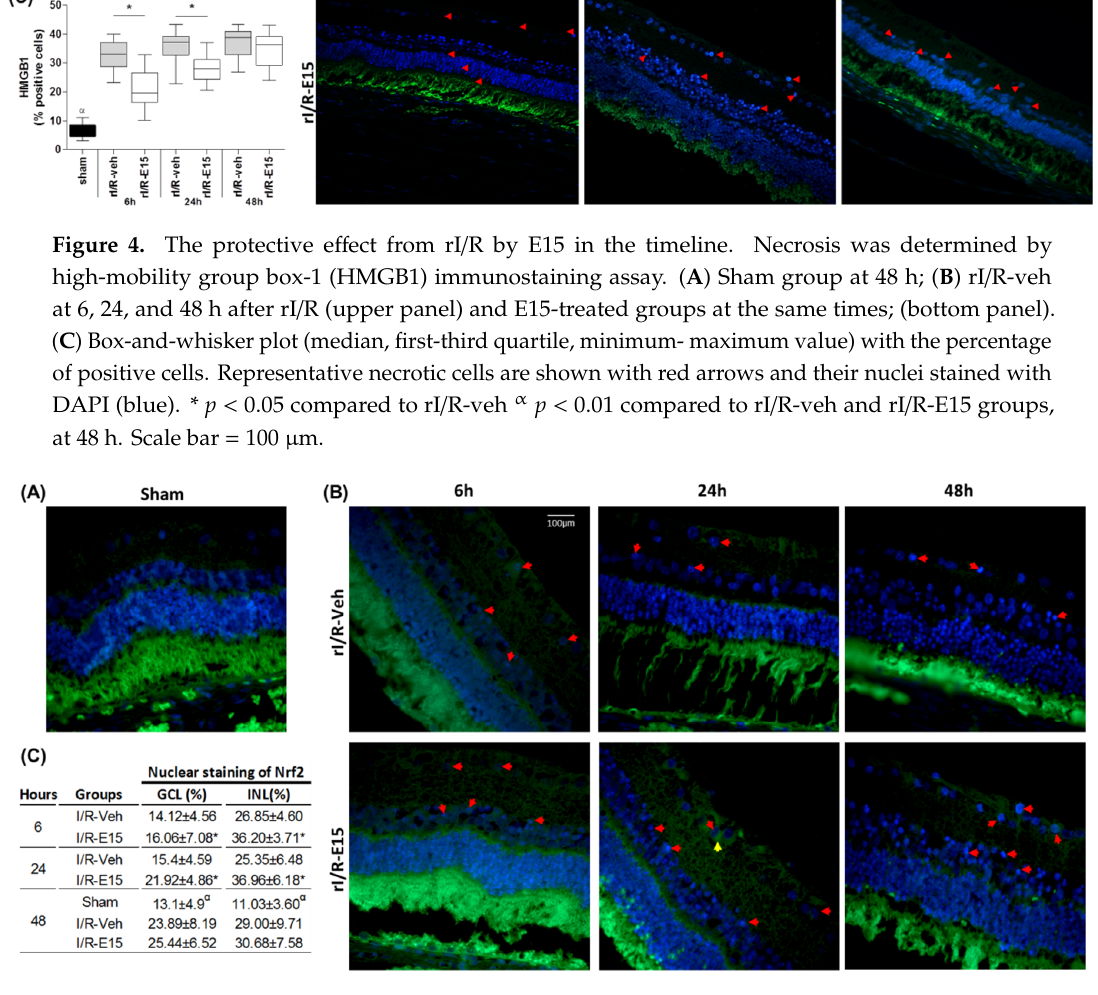
Figure 4. The protective effect from rI/R by E15 in the timeline. Necrosis was determined by high-mobility group box-1 (HMGB1) immunostaining assay. ( A ) Sham group at 48 h; ( B ) rI/R-veh at 6, 24, and 48 h after rI/R (upper panel) and E15-treated groups at the same times; (bottom panel). ( C ) Box-and-whisker plot (median, first-third quartile, minimum- maximum value) with the percentage of positive cells. Representative necrotic cells are shown with red arrows and their nuclei stained with DAPI (blue). * p < 0.05 compared to rI/R-veh α p < 0.01 compared to rI/R-veh and rI/R-E15 groups, at 48 h. Scale bar = 100 μm.